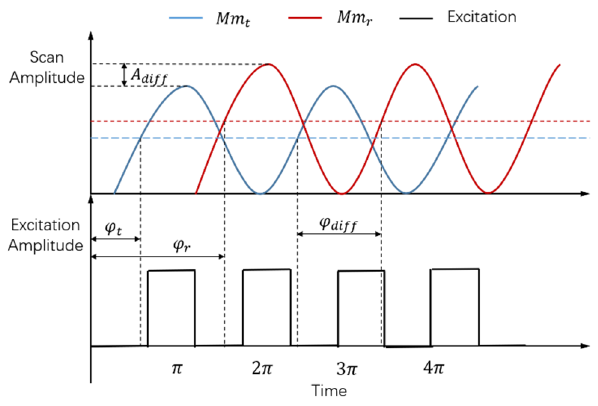
Figure 2. Diagram of MEMS mirror motion differences.